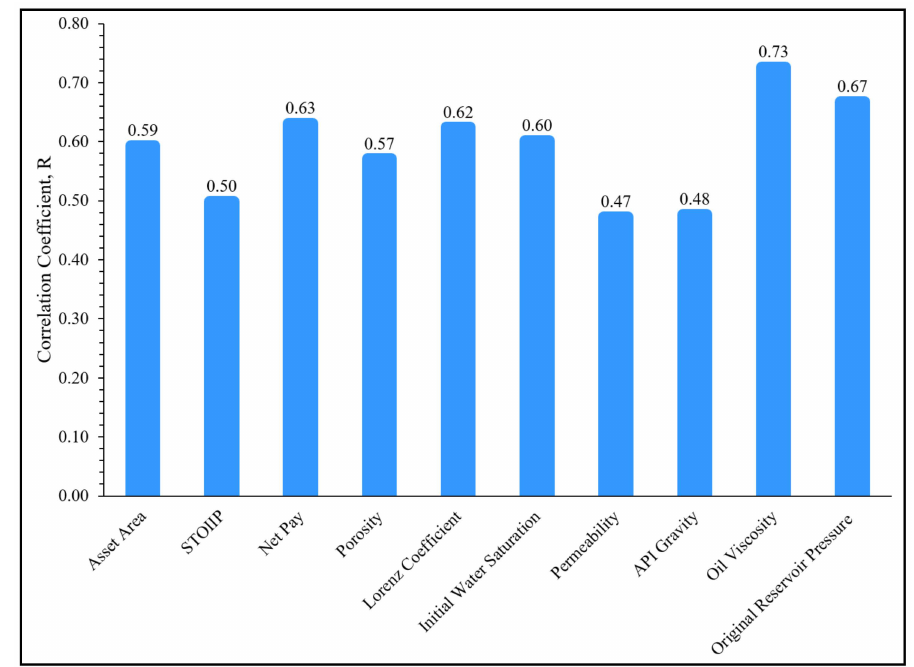
Figure 1. The relative importance of the parameters used to train the AI models developed in this study to estimate the recovery factor